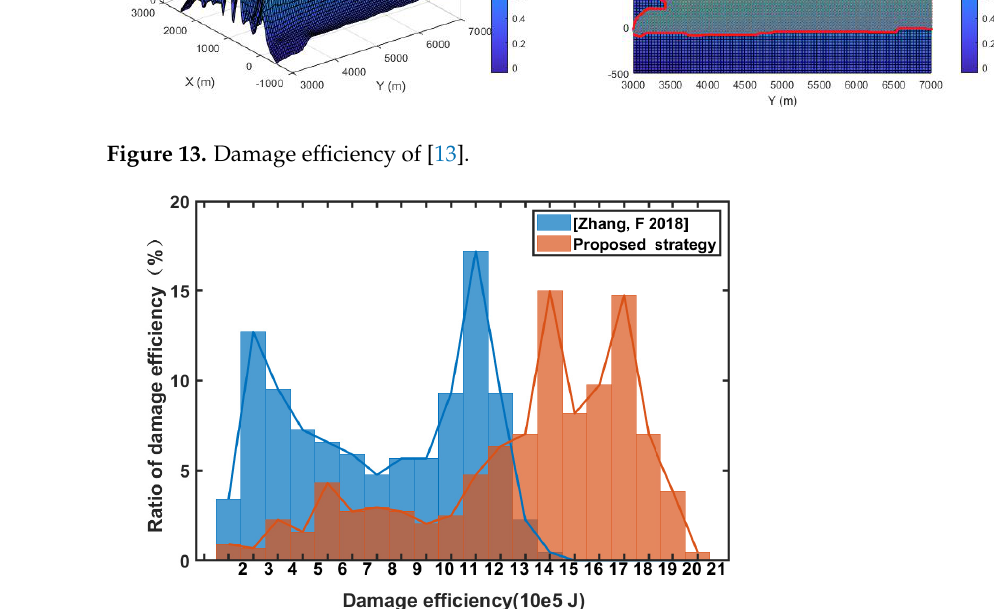
Figure 14. Histogram of the proportional distribution of damage efficiency